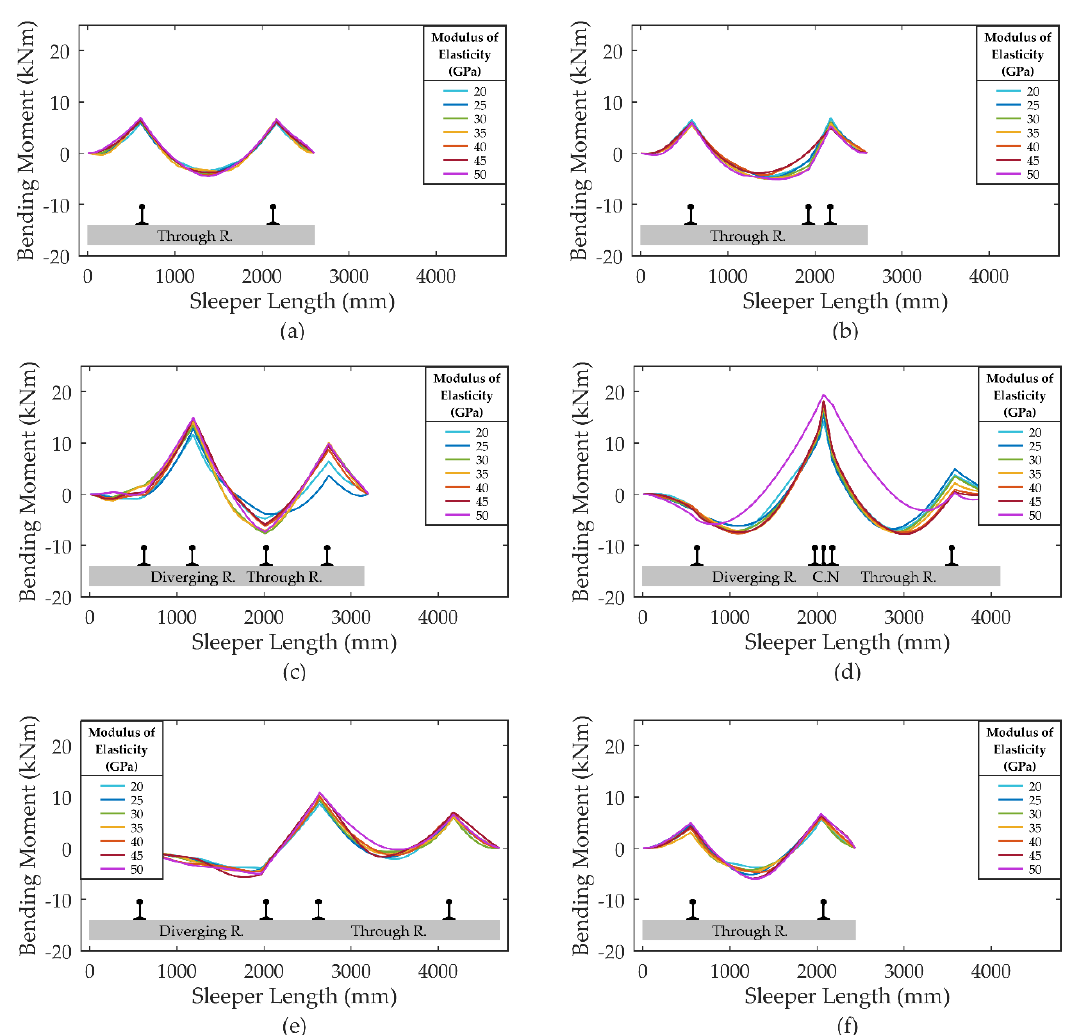
Figure 14. Bending moment distributions of specific sleepers with reference to different moduli of elasticity: ( a ) sleeper at the entrance; ( b ) sleeper under the switch blades; ( c ) sleeper at the closure panel; ( d ) sleeper under the crossing nose; ( e ) the longest sleeper; ( f ) the shortest sleeper.